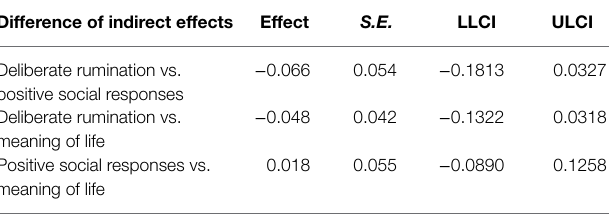
TABLE 4 | Comparison between the indirect effects of deliberate rumination, positive social responses, and meaning of life. Difference of indirect effects